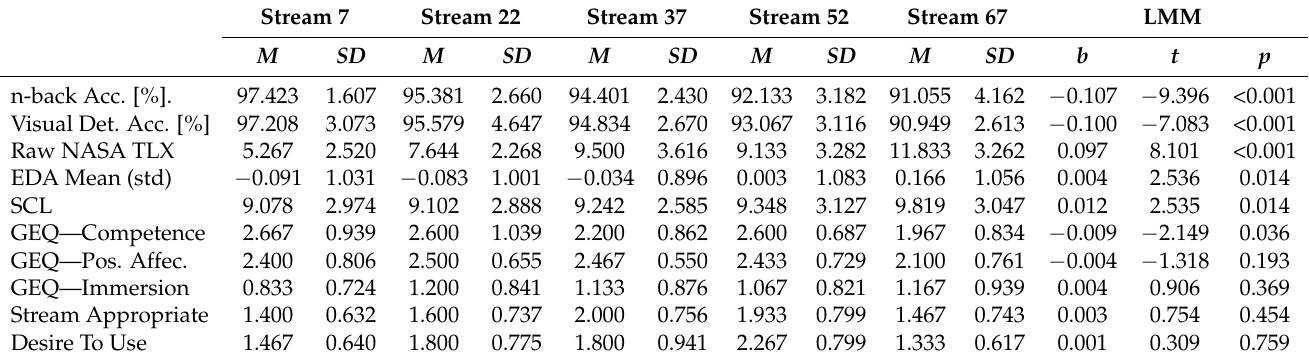
Table 1. Means across non-adaptive conditions with the slope of linear mixed models (LMM) and their t -values estimated by Wald approximation, as well as their respective p -value.